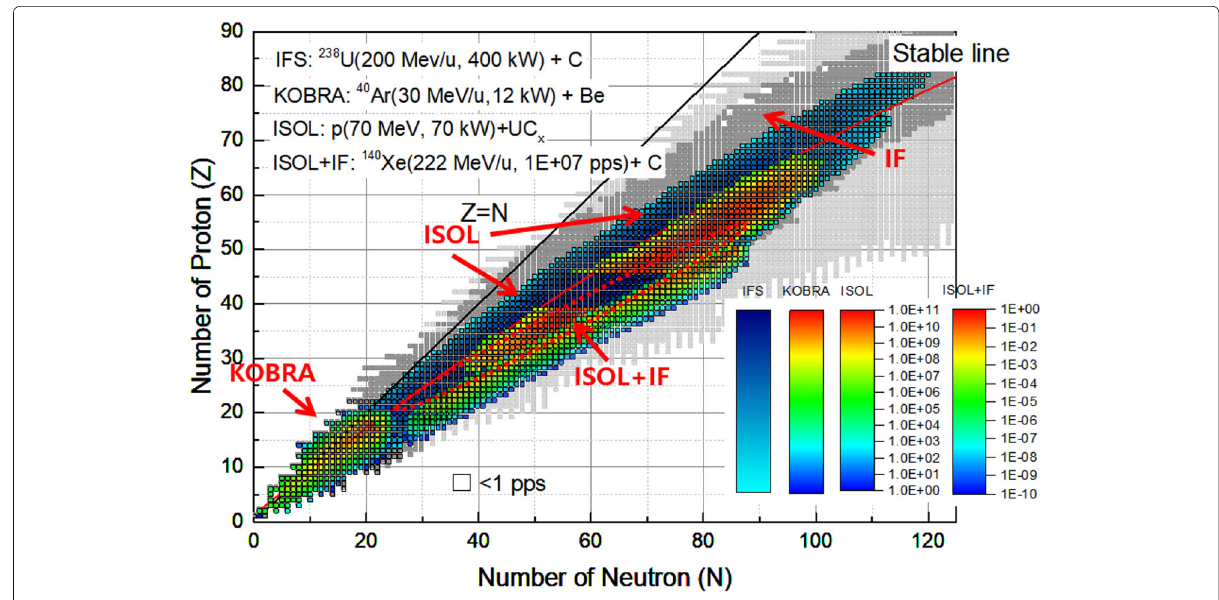
Fig. 9 The nuclear chart with expected rare isotope beams and their rates in unit of pps, produced by the KoBRA spectrometer, ISOL, IF, and ISOL+IF methods at